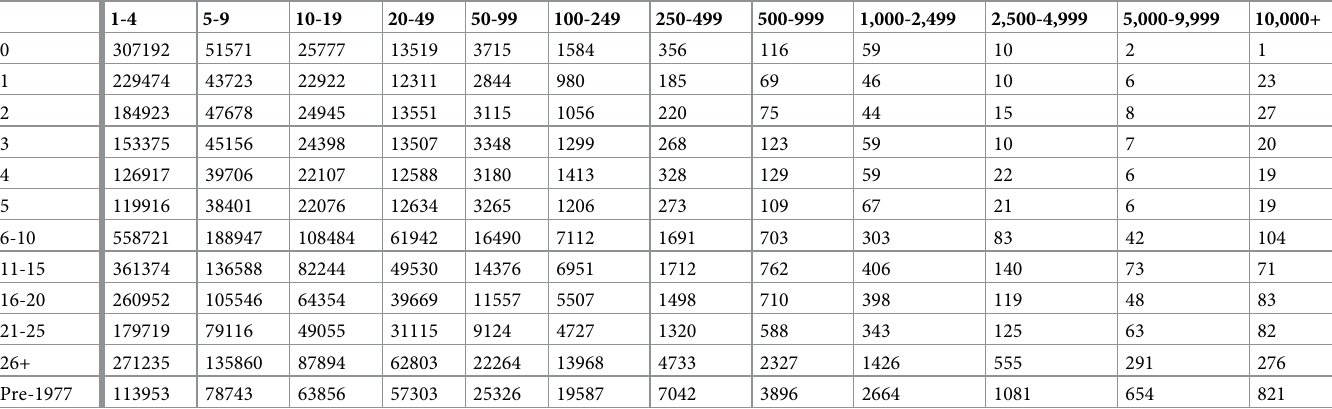
Table 1. Frequency distribution of 2014 US private-sector firms by size and